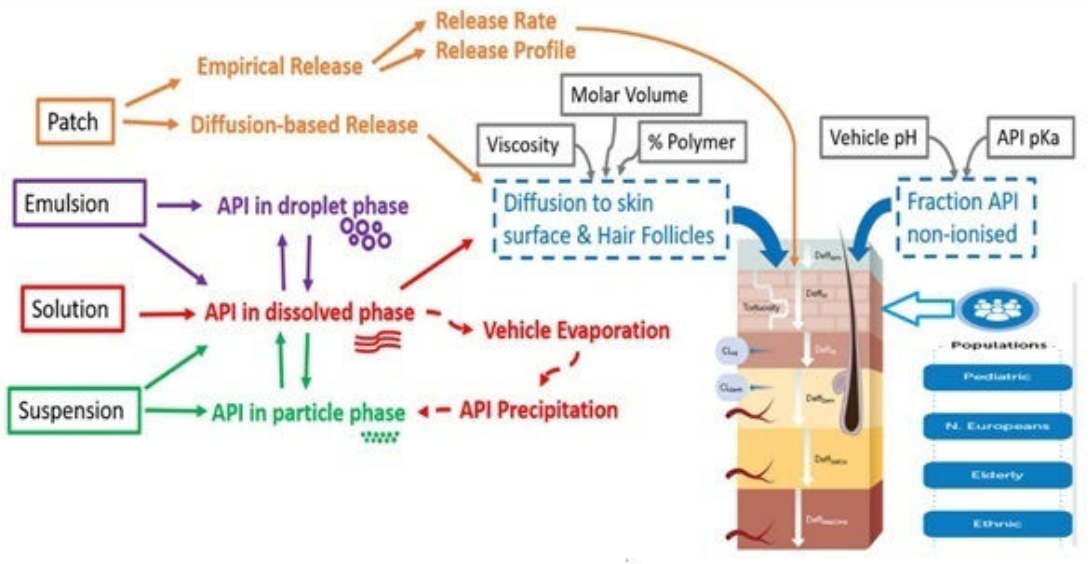
Figure 2. The Multi-Phase Multi-Layer Mechanistic Dermal Absorption (MPML-MechDermA)